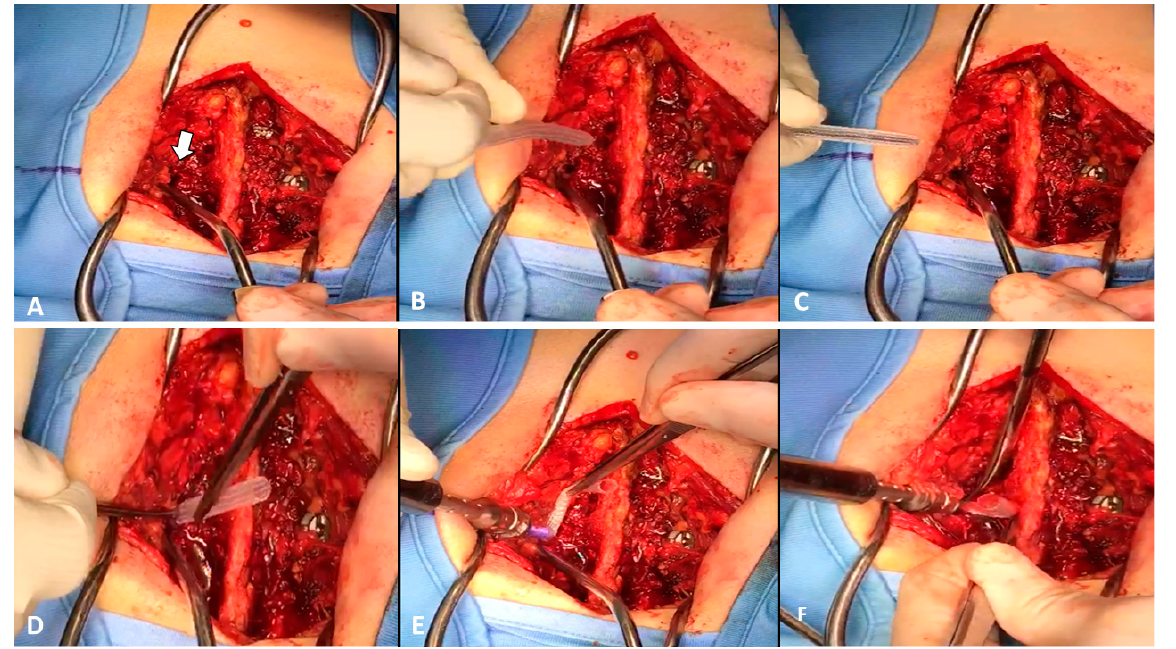
Figure 4. Intraoperative imaging . ( A ) Pedicle hole for screw insertion (white arrow); ( B ) The sleeve over the pedicle probe; ( C ) The pedicle probe, inserted through the hole, to help pedicle insertion; ( D ) pushing the sleeve inside the pedicle hole with the pedicle probe; ( E ) Screw placement inside the OGmend ® sleeve; ( F ) After complete insertion the sleeve excess is cut with scissors. The procedure was well tolerated and had no immediate post-operative complications. At 3 months, the patient was pain-free, and the incisions were healed with no evidence of prominent instrumentation. The radiographs showed that the instrumentation was intact and well-aligned (Figure 5).